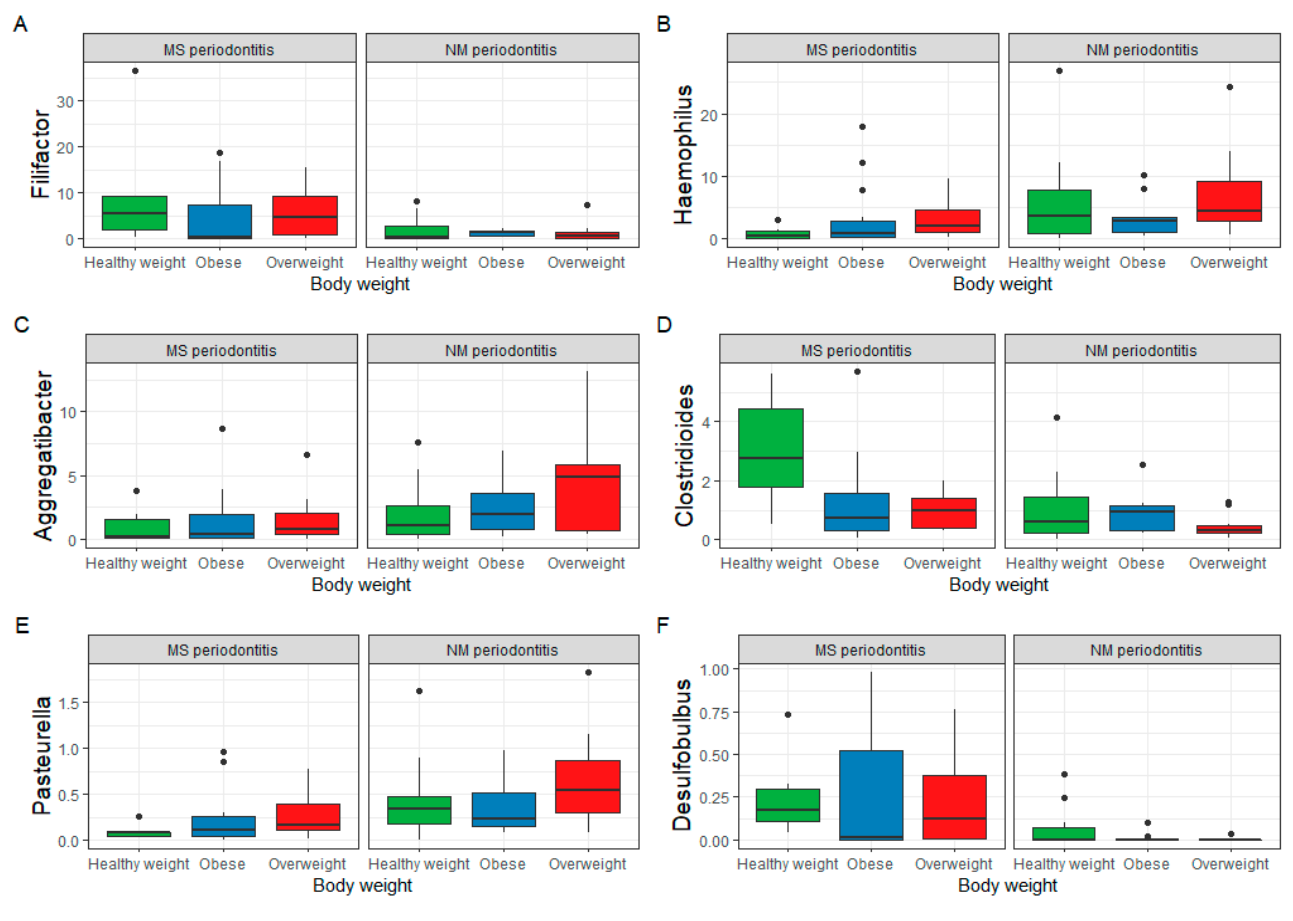
Figure 3. Top 6 genera with significant variations among the study groups (LDA score above 4) based on the linear discriminant analysis (LDA) effect size (LEfSe) for genera with significantly different abundance among groups differentiated on the basis of periodontal health status and BMI. Box plots show Q1-median-Q3 with range. Black dots are outlier values.